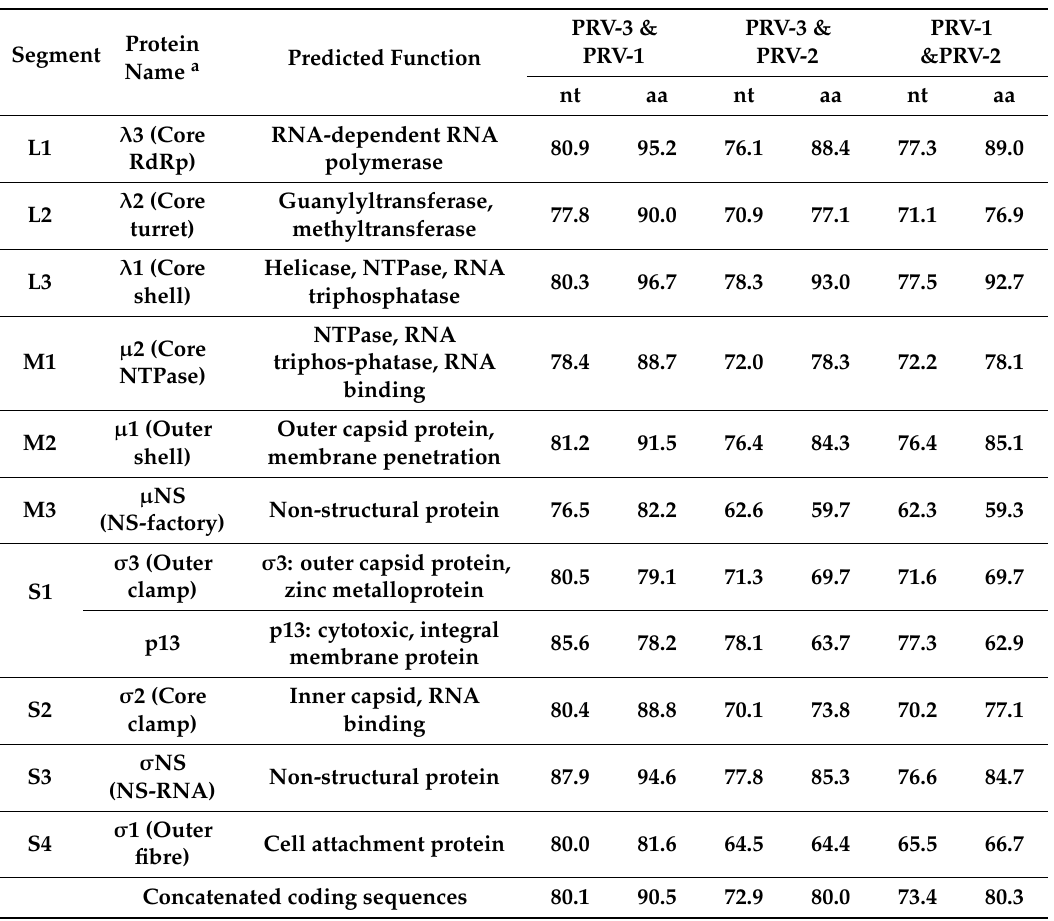
Table 1. Identities of nucleotide and amino acid sequences of ORFs of PRV-1, -2, and -3. a Protein nomenclature is based on